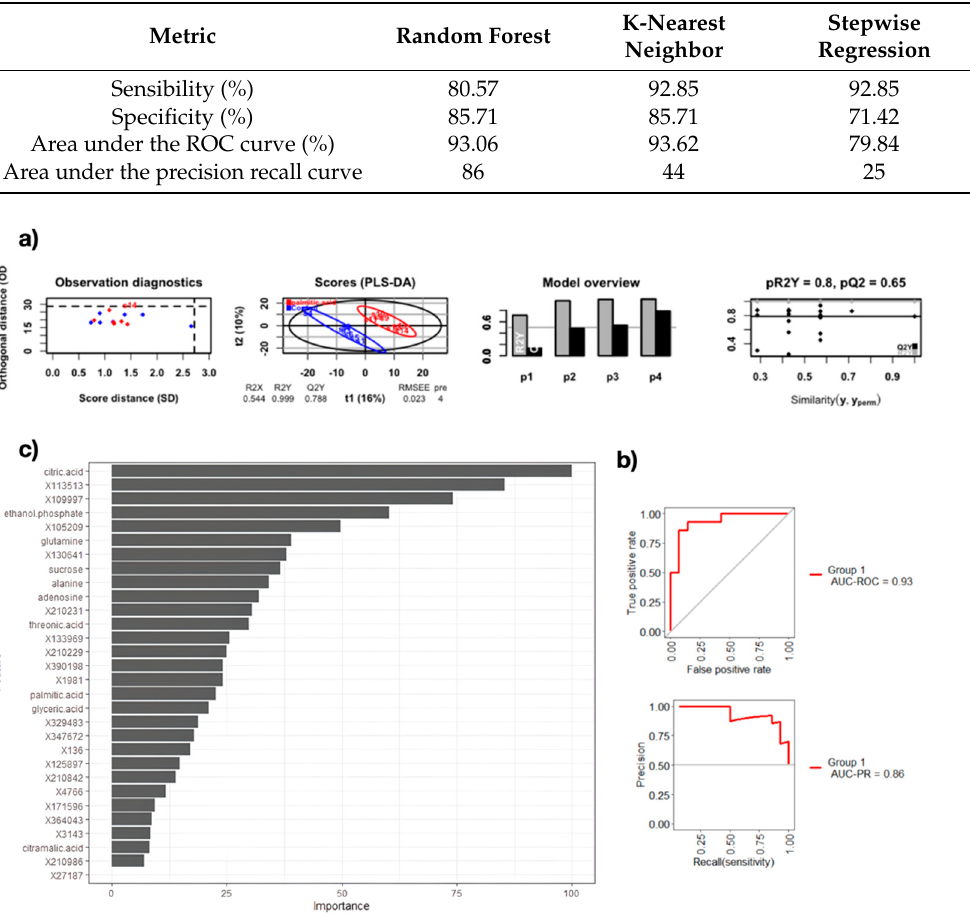
Figure 2. Feature selection and model performance. ( a ) PLS–DA analysis for comparing palmitic acid and control treatments from which several metabolites were extracted as features for further modeling. ( b ) Random forest ROC and precision recall curves. ( c ) Most important features (metabolites) of the random forest model. The figure was created using R software version 4.0.5. R2 means fraction of variance explained by a component and Q2 means fraction of the total variation predicted by a component.